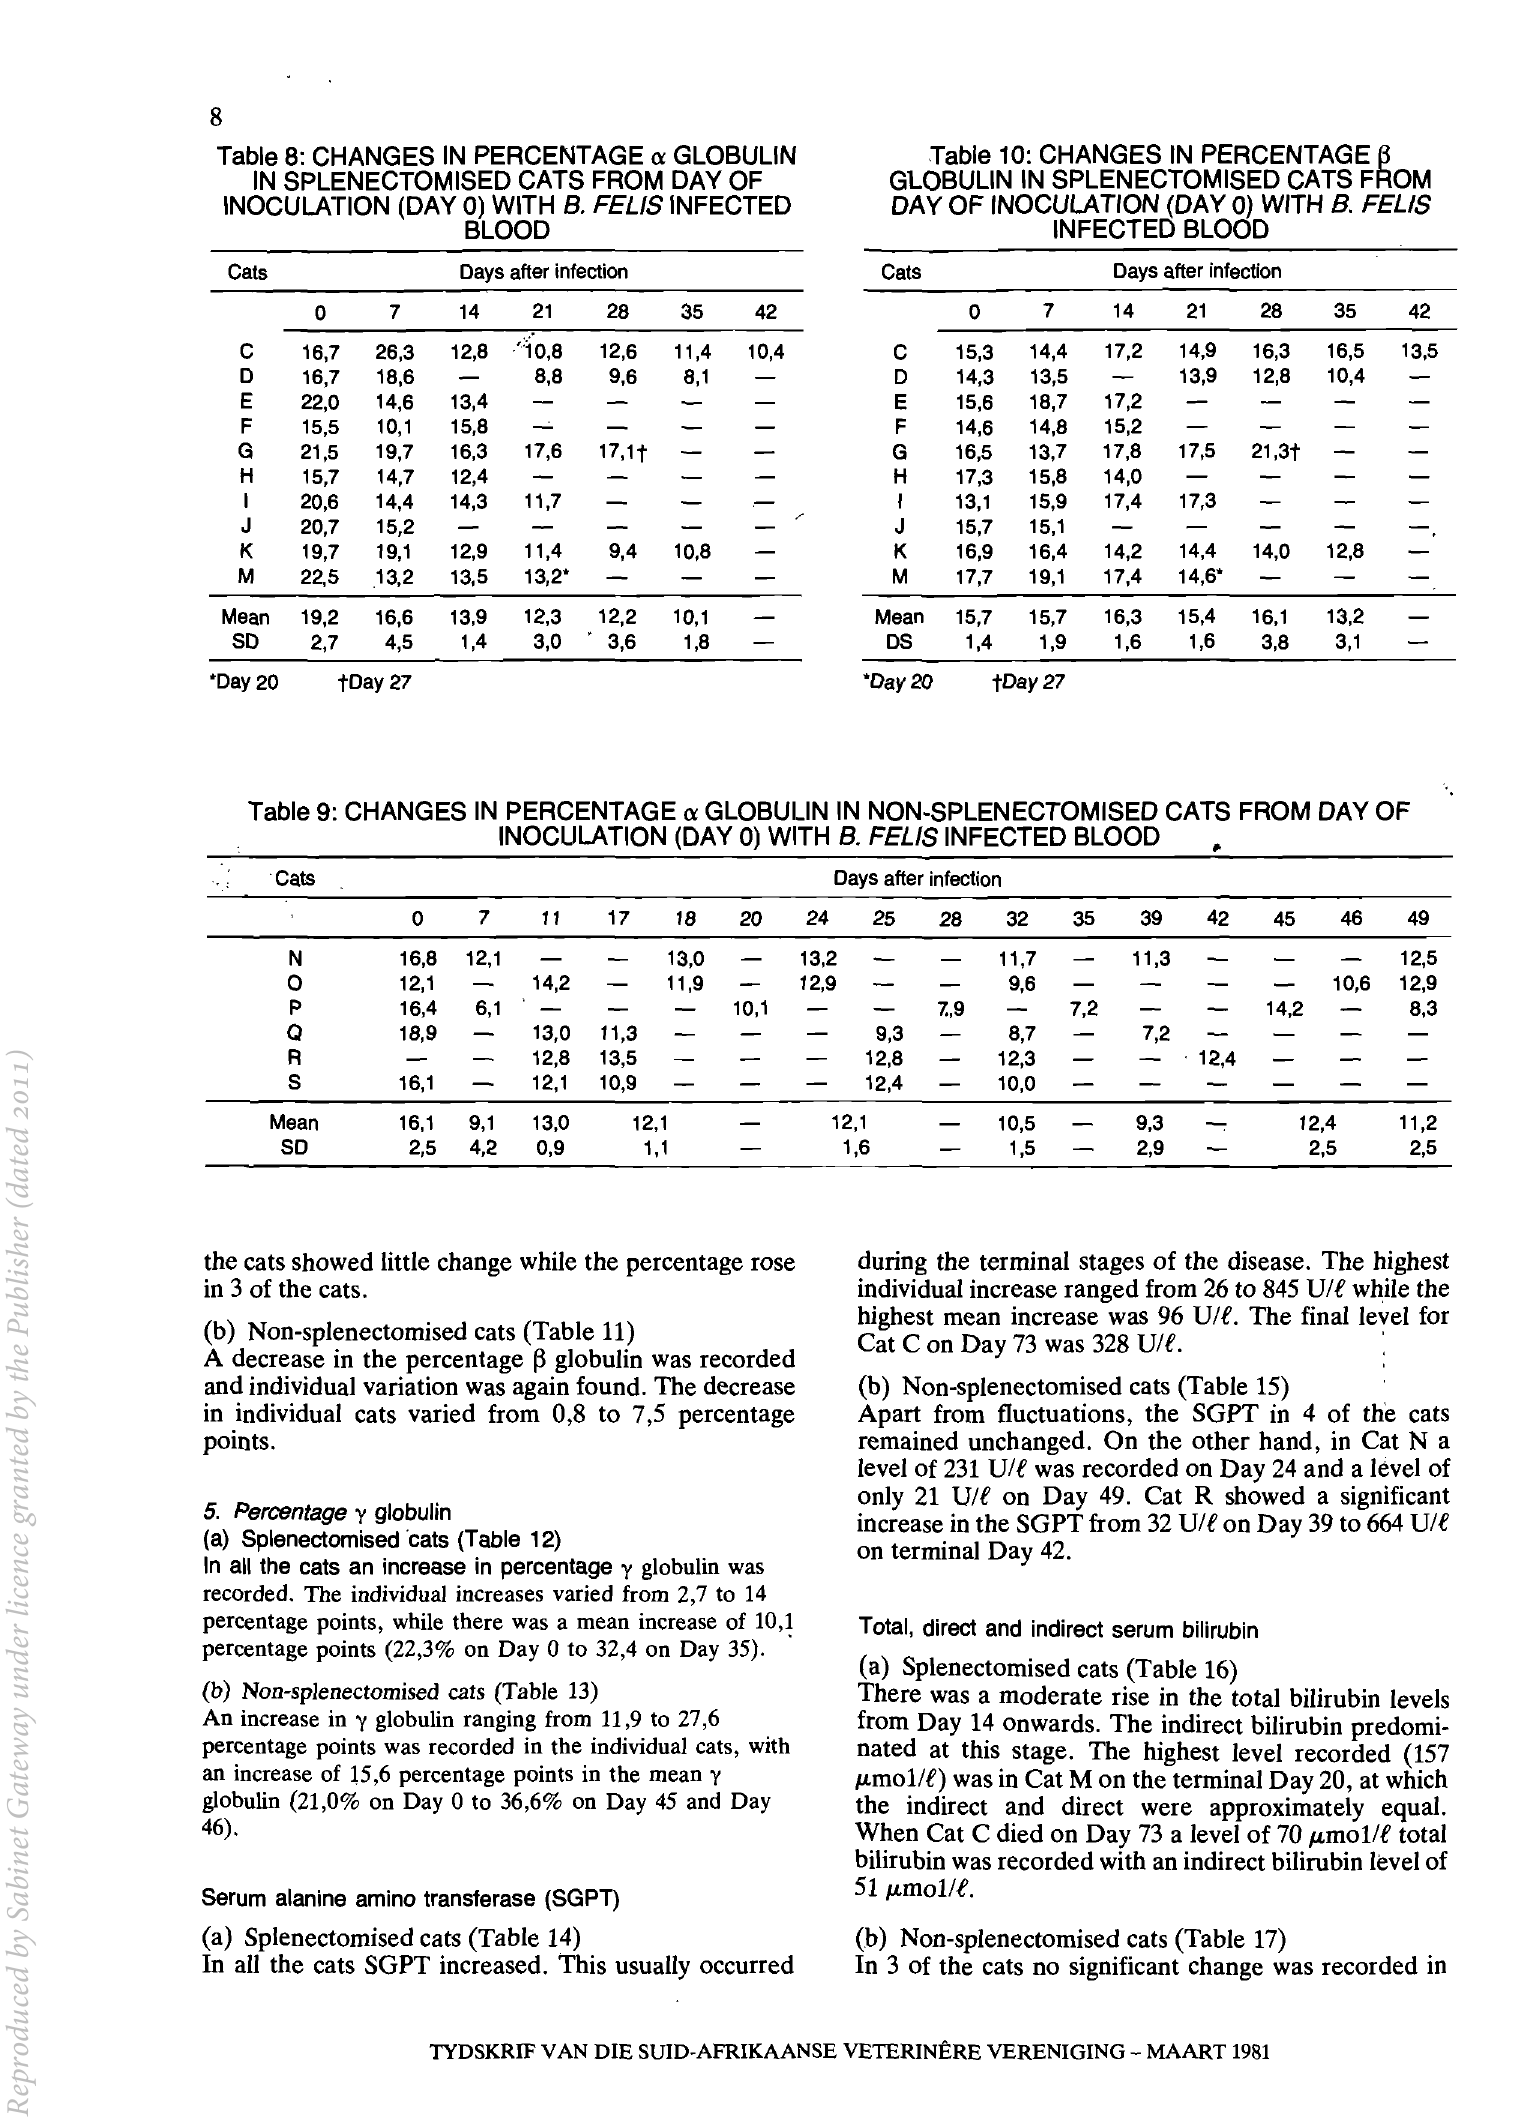
Table 8: CHANGES IN PERCENTAGE (X GLOBULIN Table 10: CHANGES IN PERCENTAGE ~ IN SPLENECTOMISED CATS FROM DAY OF GLOBULIN IN SPLENECTOMISED CATS F OM INOCULATION (DAY 0) WITH B. FELIS INFECTED BLOOD